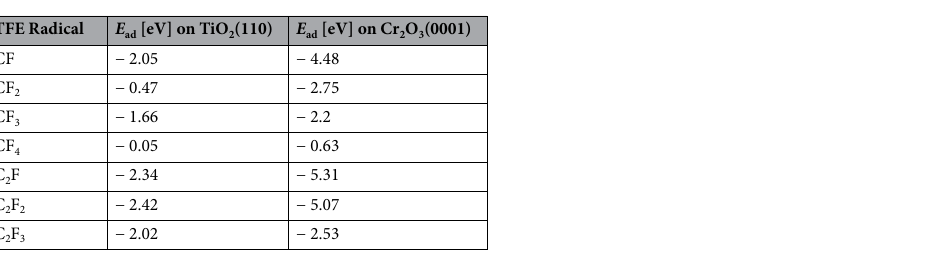
Figure 6. Charge density difference for C 2 F 3 + F on TiO 2 (110) (upper left panel) and Cr 2 O 3 (0001) (upper right panel). Yellow to red region indicates electron gain. Light blue to dark blue region indicates electron loss. Projected density of states for C 2 F 3 + F on TiO 2 (110) (lower left panel) and Cr 2 O 3 (0001) (lower right panel).